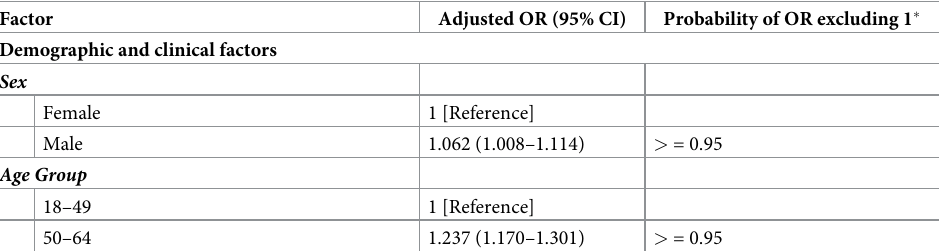
Table 3. Results of a Bayesian regression analysis, adjusted for demographic/clinical, occupational, and social risk factors, on increased likelihood to vaccinate after doctor/nurse